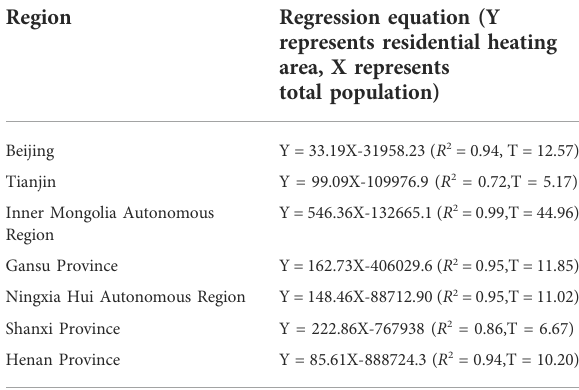
TABLE 4 Regression equation of total population and residential heating area in other areas of central heating area. Region Regression equation (Y represents residential heating